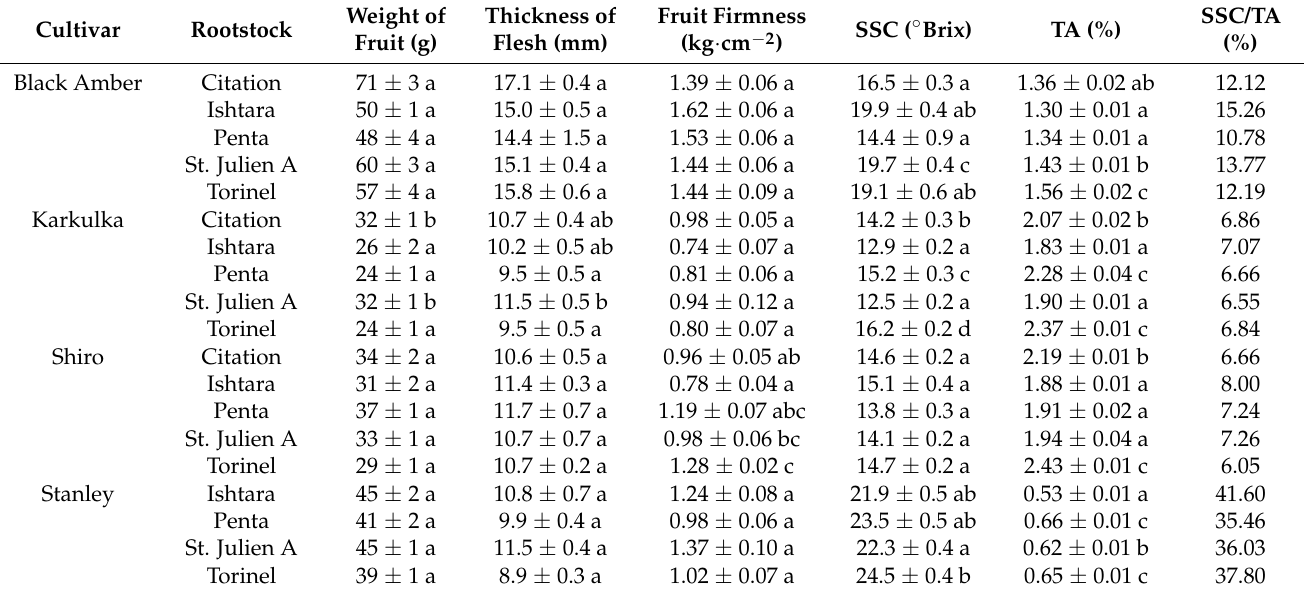
Table 2. The pomological data, fruit firmness, SSC, and titratable acid content (TA) of plum cultivars with different